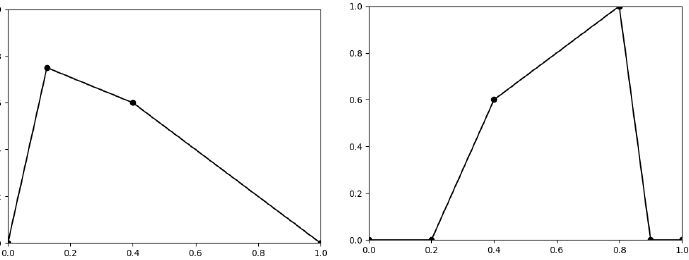
Figure 6. The graphs of the function g 1 given by 4 points ( left ) and the fuzzy set A 1 given by 6 points ( right ).